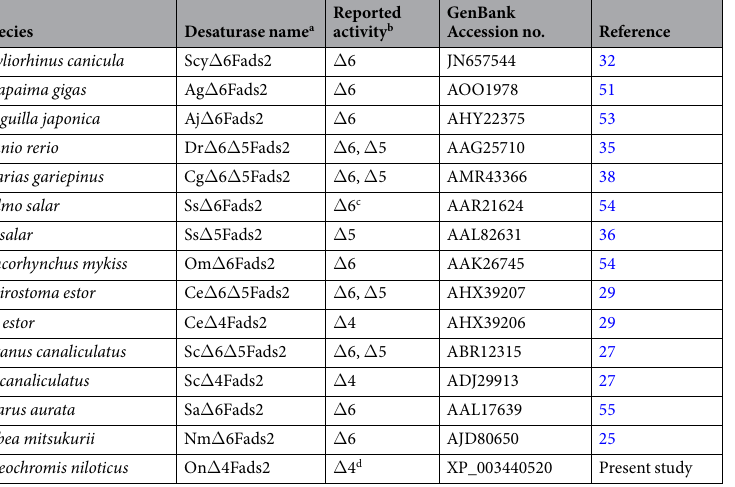
Table 3. Fish fatty acyl desaturases (Fads) investigated for the ability to desaturate tetracosapentaenoic acid (24:5n − 3) to tetracosahexaenoic acid (24:6n − 3). Their known desaturation activities and the studies in which they were published are indicated accordingly. a Scy, Scyliorhinus canicula; Ag, Arapaima gigas; Aj, Anguilla japonica; Dr, Danio rerio; Cg, Clarias gariepinus; Ss, Salmo salar; Om, Oncorhychus mykiss; Ce, Chirostoma estor; Sc, Siganus canaliculatus; Sa, Sparus aurata; Nm, Nibea mitsukurii; On, Oreochromis niloticus. b Δ 8 desaturase activities of some of these desaturases and reported in the corresponding publication are not indicated in the interests of clarity. c Refers to “Fads2_a” as termed by Monroig et al . 56 . d Functional characterisation of On Δ 4Fads2 was carried out in the present